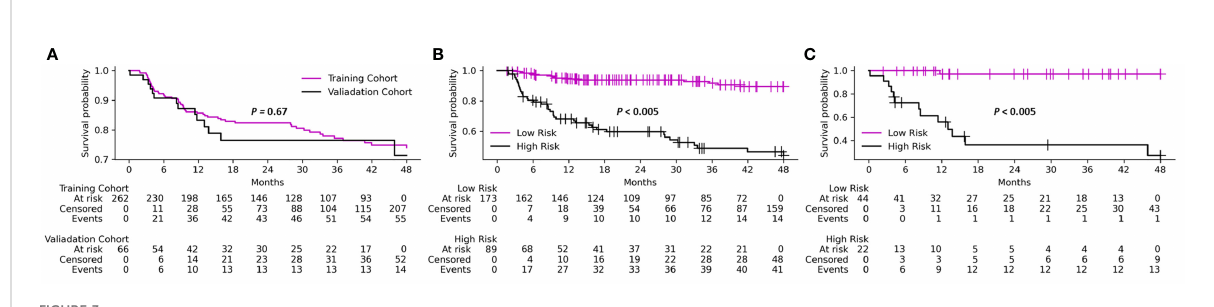
FIGURE 3 Kaplan-Meier analysis of local persistence/recurrence free survival on (A) training and validation cohorts, (B) identi fi ed low- and high-risk patient groups on training cohort, (C) identi fi ed low- and high-risk patient groups on validation cohort. P-values are calculated using log-rank